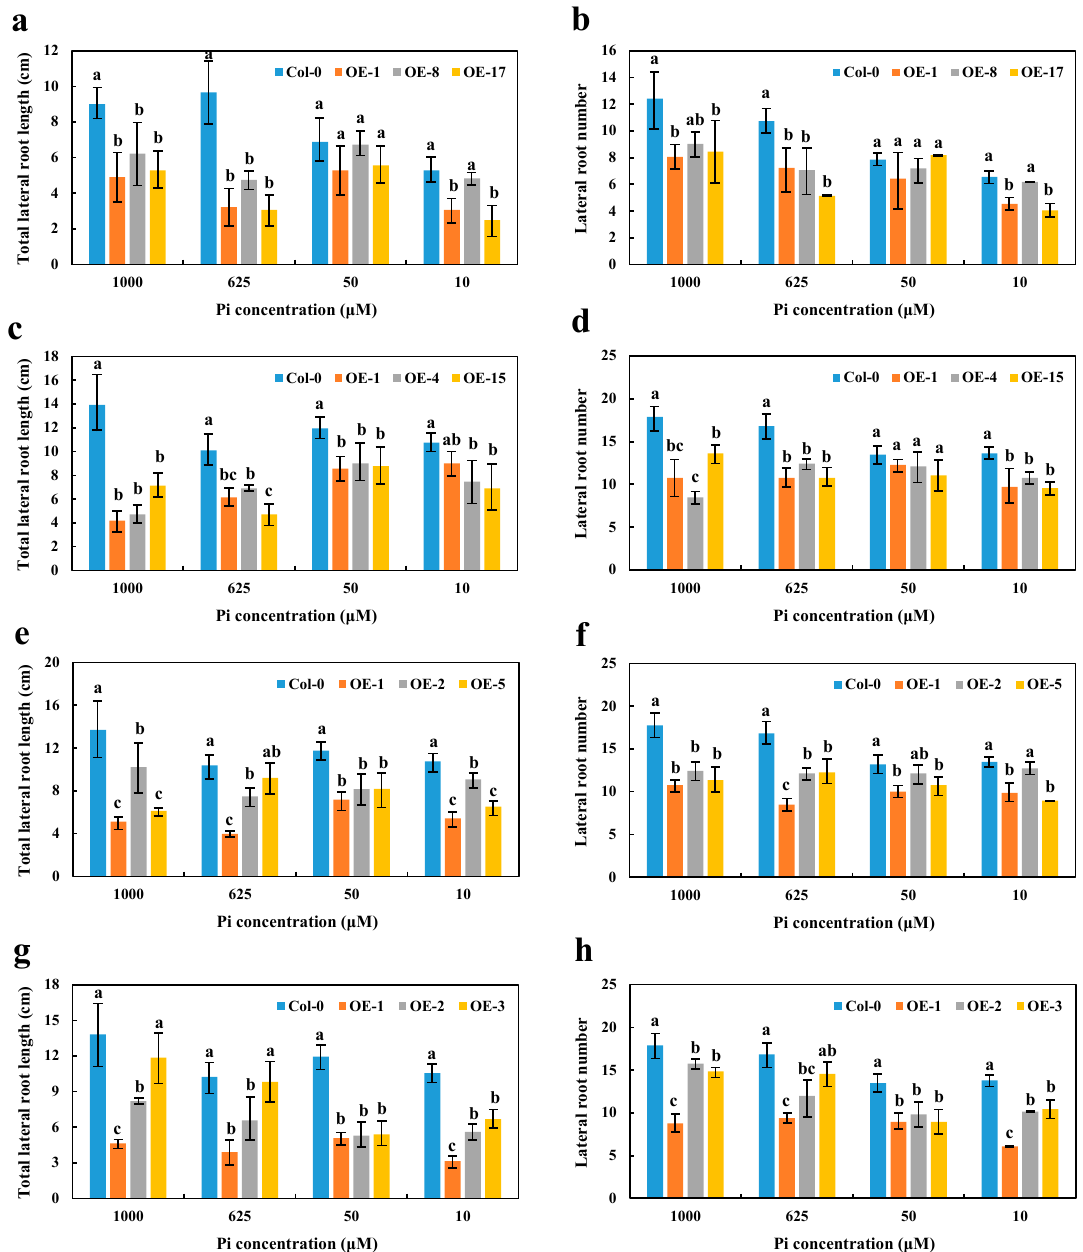
Figure 7. Comparison of the lateral root number and lateral root length among the OE BnaCRF8 lines and Col-0 at varied Pi conditions. Eleven-day-old plants grown on 10, 50, 625, and 1000 µ M Pi were imaged for measurement of the lateral root number and length. ( a , b ) OE BnaA7.CRF8 lines; ( c , d ) OE BnaC2.CRF8 lines; ( e , f ) OE BnaCn.CRF8 lines; ( g , h ) OE BnaA2.CRF8 lines. Statistics were performed by Duncan’s test at the significance level of p < 0.05. Values represent mean ± SD, n = 4 replicates of 20 seedlings each. Small letters (a, b, and c) above the bars indicate mean with significant differences at p < 0.05 by Duncan’s test.